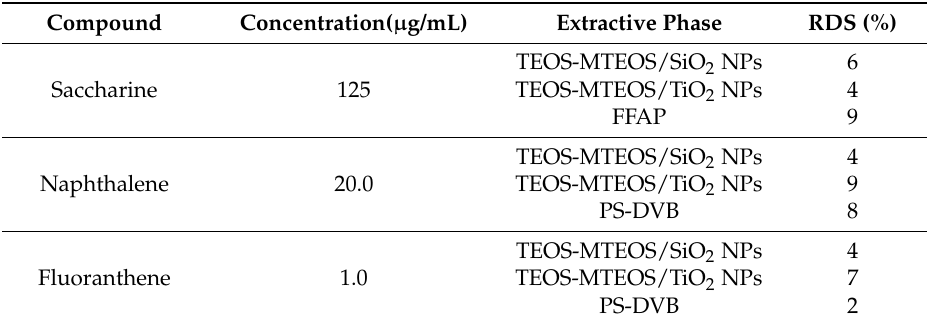
Table 2. Reproducibility obtained by IT-SPME–Cap-LC with the trimethoxyethylsilane (TEOS-MTEOS) capillaries functionallized with nanoparticles (NPs) and the commercial capillary that gave the best extraction rate for each compound (n = 3); volume of sample processed, 200 µ